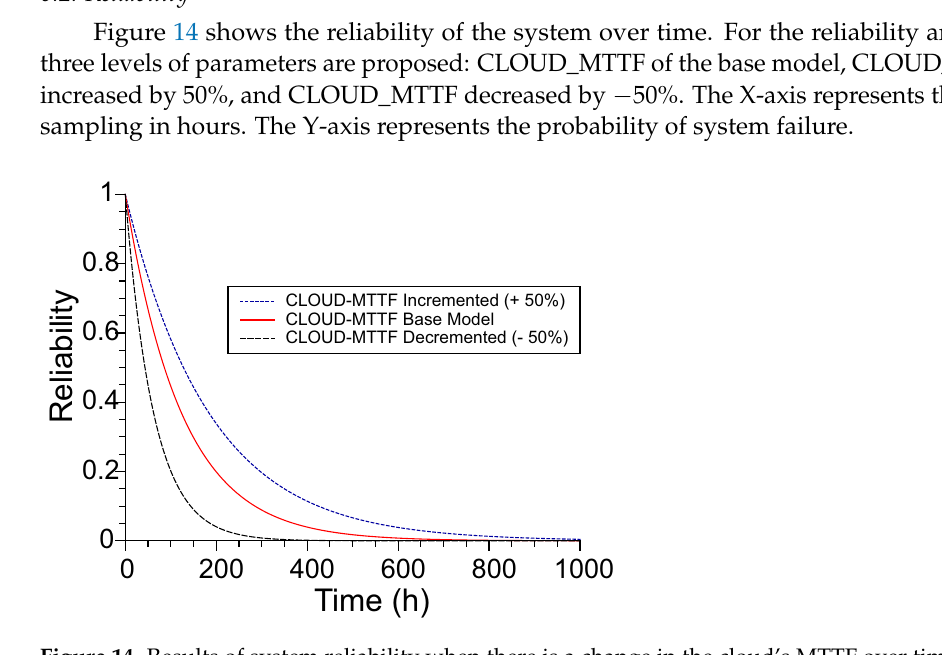
Figure 14. Results of system reliability when there is a change in the cloud’s MTTF over time. The reliability levels are very different from each other. Analyzing the lines at all levels, they follow a decreasing probabilities pattern as the operating time progresses. At to decrease exponentially. As the failure time decreases, there is a tendency for a steeper curve of the line. Such behavior indicates that, with less time between failures, the